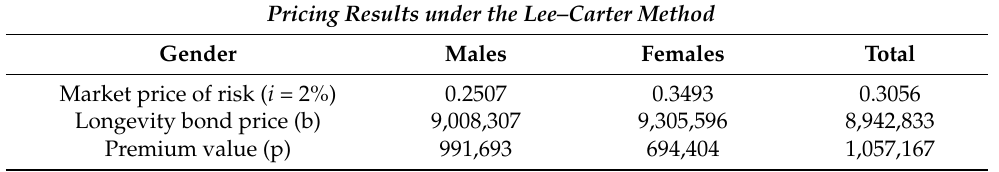
Table 3. The market price of risk and the longevity bond pricing results under the Lee–Carter method, based on males, females, and annuitants from the total population of